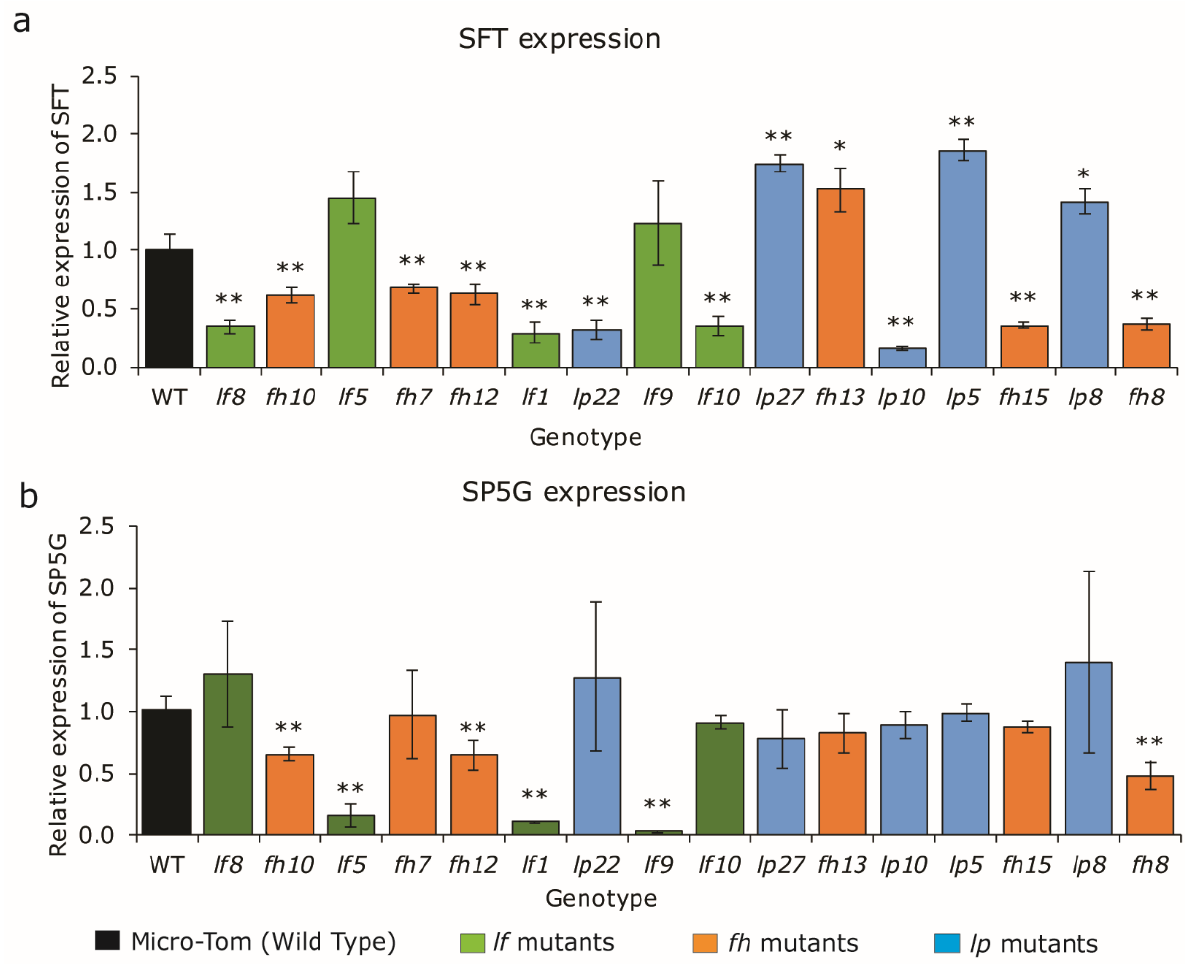
Figure 4. Examination of SFT ( a ) and SP5G ( b ) expression from mature leaves to assess the correlation between flowering time and floral hormone. Three phenotypic mutant groups categorized as lf (green color bars), fh (orange color bars), and lp mutants (blue color bars) were arranged by PSM according to leaf number produced. Mean values ( ± SD) were compared to those for wild-type and mutants categorized into three groups using Student’s t -tests (*, p < 0.05; **, p < 0.01).